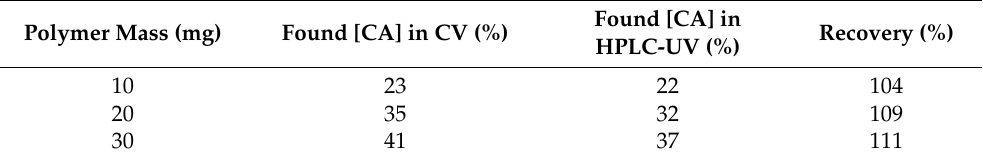
Table 3. Percentage of CA determined by cyclic voltammetry using MIP6 and by HPLC-UV in com- parison with the spiked quantity. The recovery percentage indicates how close these two values are.